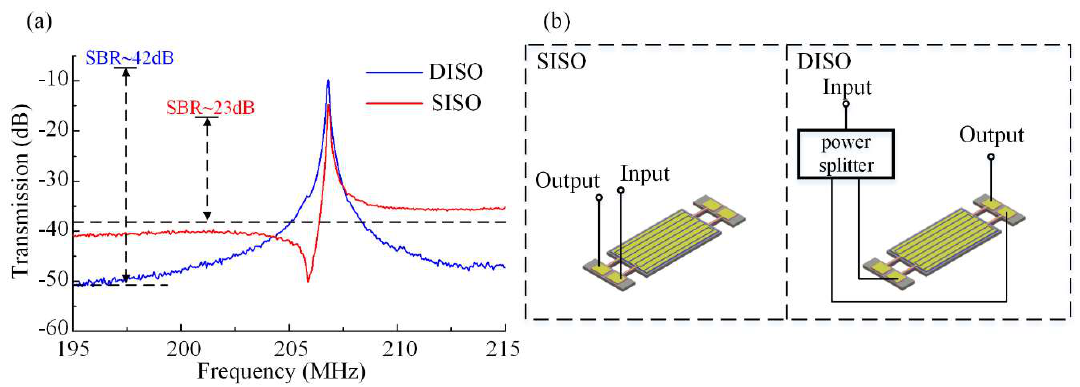
Figure 10. Comparison of the electrical transmission of the proposed resonator working in SISO and DISO setups. ( a ) The red trace is the results for SISO, and the response of the DISO setup is shown as the blue trace. Measurement result for DISO is better than that for SISO in both insertion loss and feedthrough suppression. ( b ) Measurement configurations of resonator operating in SISO and DISO.